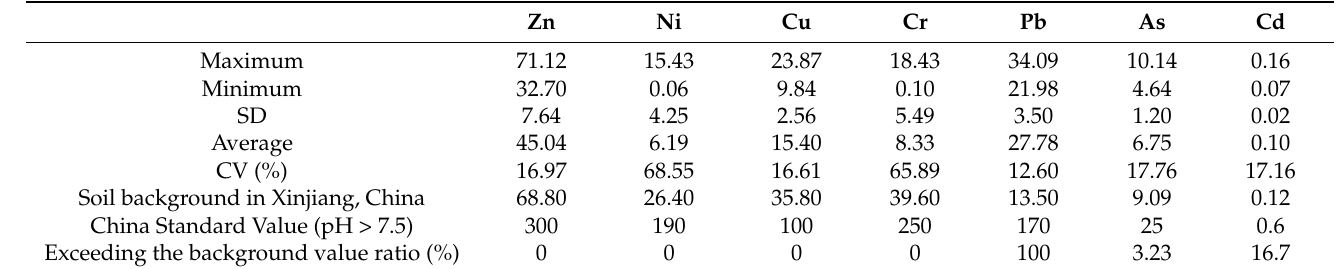
Table 2. Statistical characterization of heavy metal content of soils in drainage sites (mg/kg).